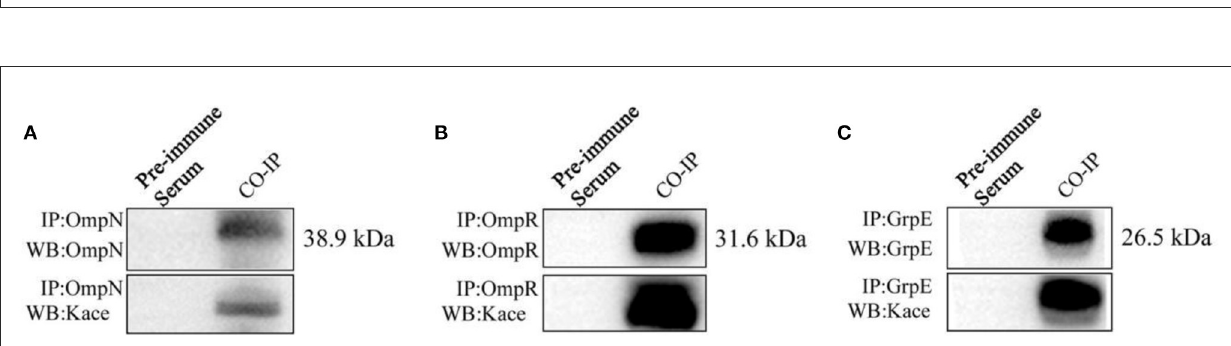
FIGURE6 Validation of OmpN (A) , OmpR (B), and GrpE (C) by Co-IP and Western blotting. OmpN, OmpR, and GrpE proteins were captured by specific antibodies (anti-OmpN, anti-OmpR, and anti-GrpE), and validation by Western blotting with anti-OmpN, anti-OmpR and anti-GrpE (above), and anti-lysine acetylation antibodies